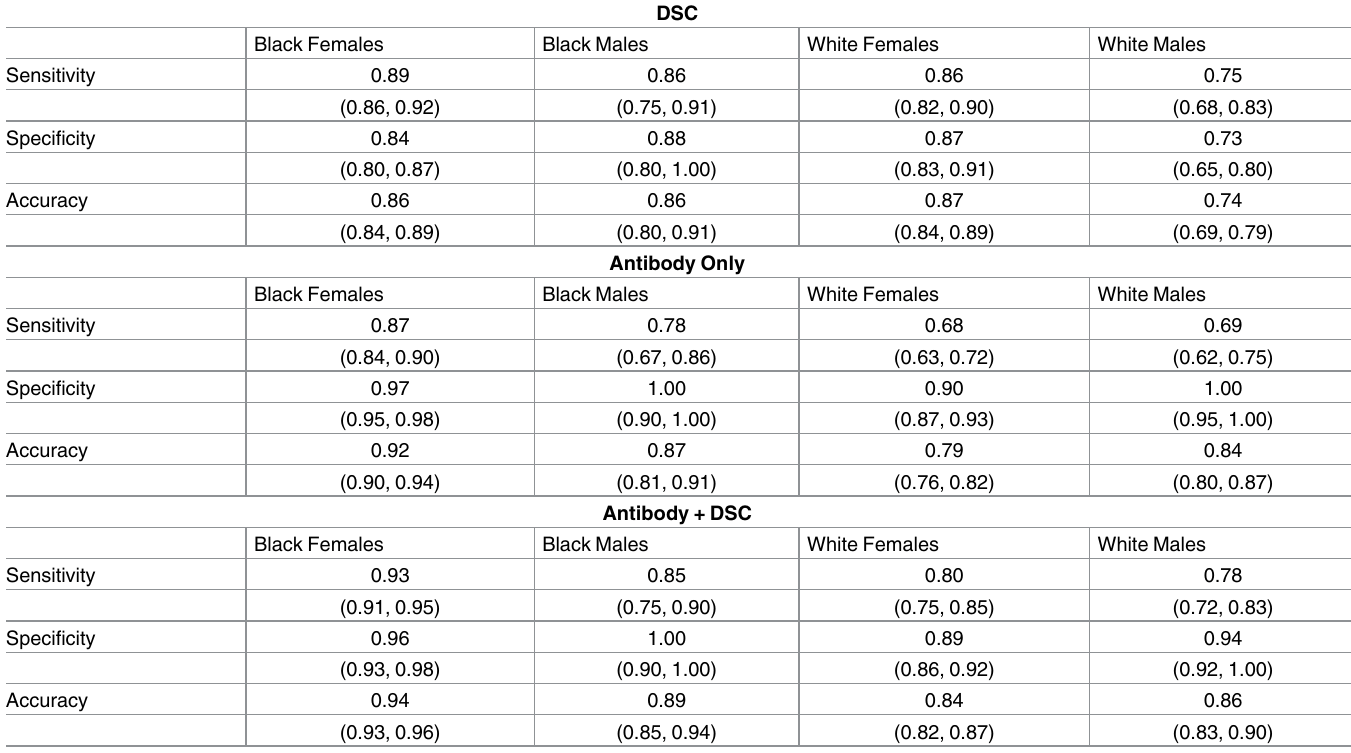
Table 2. Accuracyof DSC, antibody only, and combined antibody + DSC classifiers in patient subsets according to race and